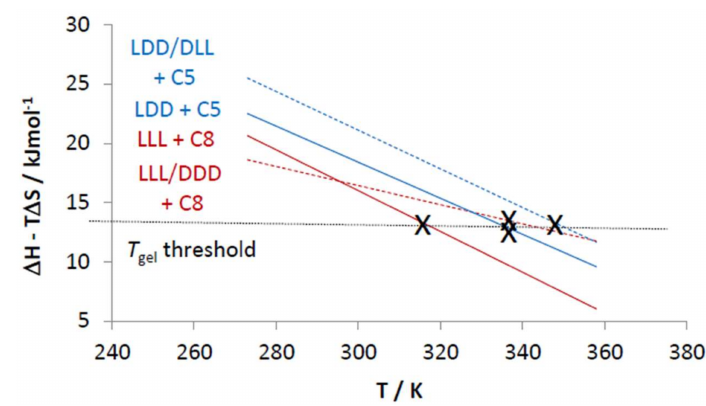
Figure 4. Plot of ∆ H − T ∆ S against temperature using the data from Table 3. X’s mark the experimental T gel values. Enantiopure systems have full lines and racemic mixtures have dotted lines. This graph highlights the differences between systems and the apparent existence of a T gel